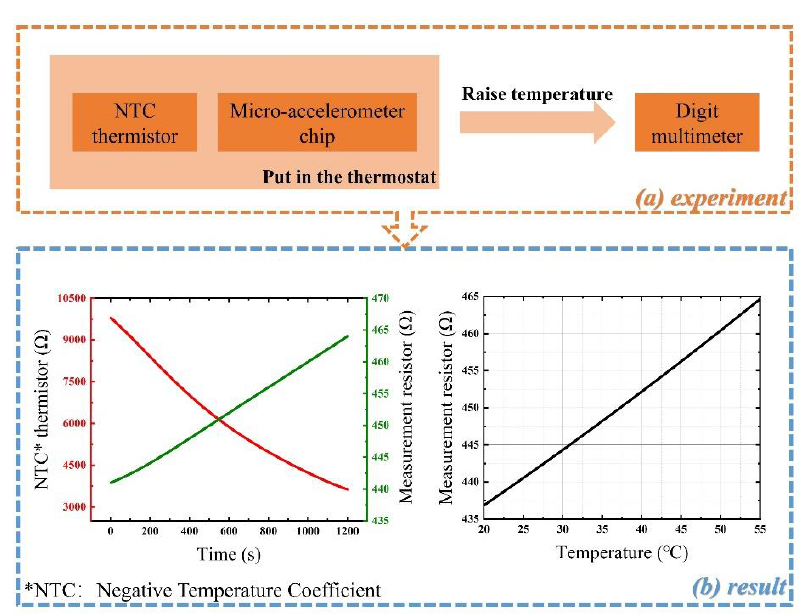
Figure 2. Measurement resistor calibration experiment flow chart.